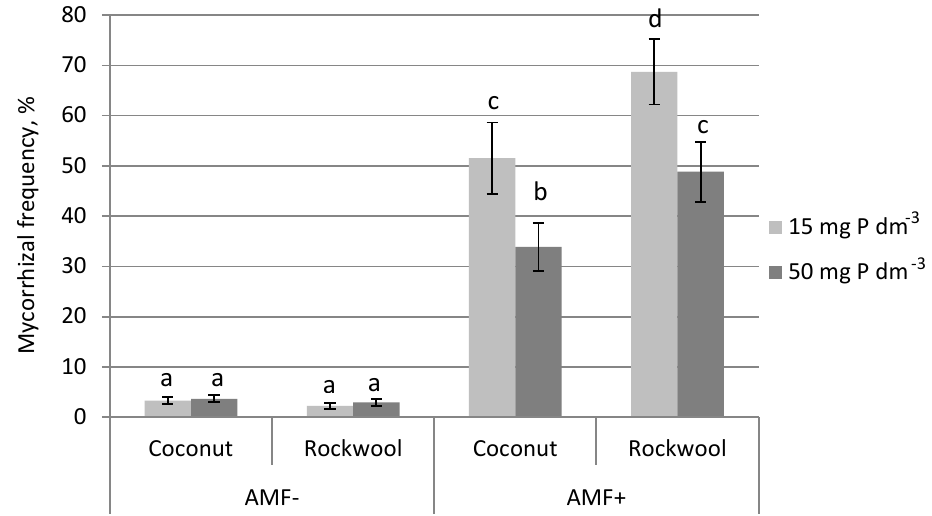
Fig. 2. Interaction between phosphorus level in nutrient solution, mycorrhiza and type of substrate on mycorrhizal frequency in roots of tomato plants; 2. period of isolation (112 days after transplanting (DAT)) Means followed by different letters differ at p < 0.05.; bars indicate standard error AMF-/AMF+ – non-inoculated plants by arbuscular mycorrhizal fungi (AMF)/inoculated plants by